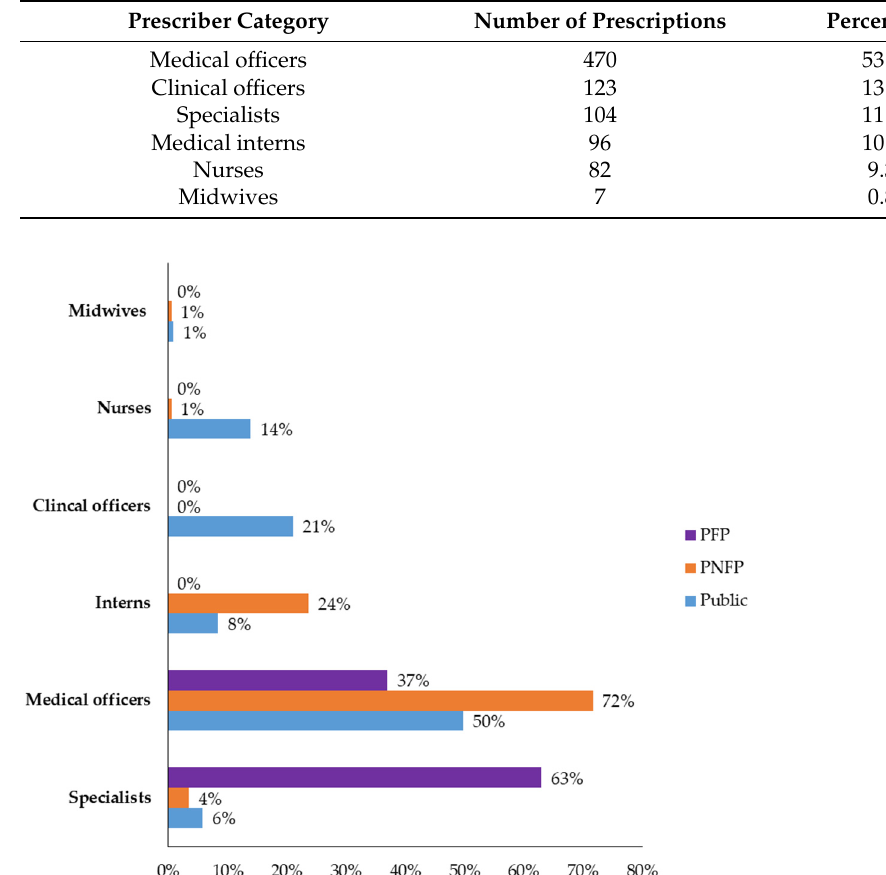
Table 1. Prescriber categories for the prescriptions reviewed ( n = 882).